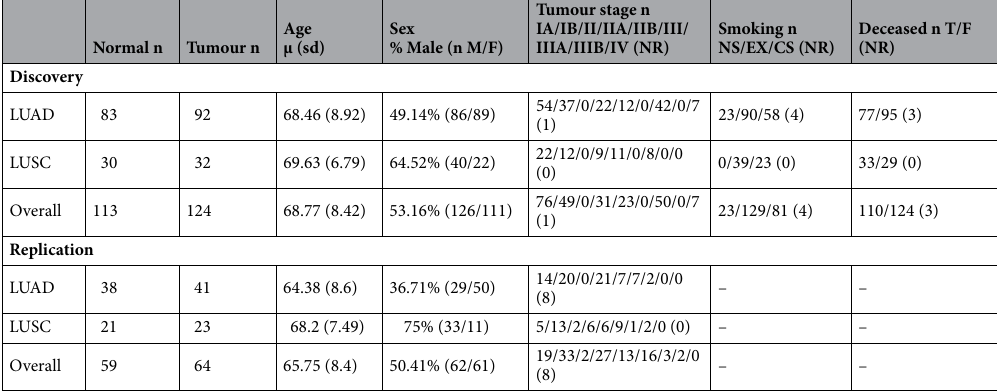
lung squamous cell carcinoma, T true, F false, NS never smoker, EX ex-smoker, CS current smoker, NR not